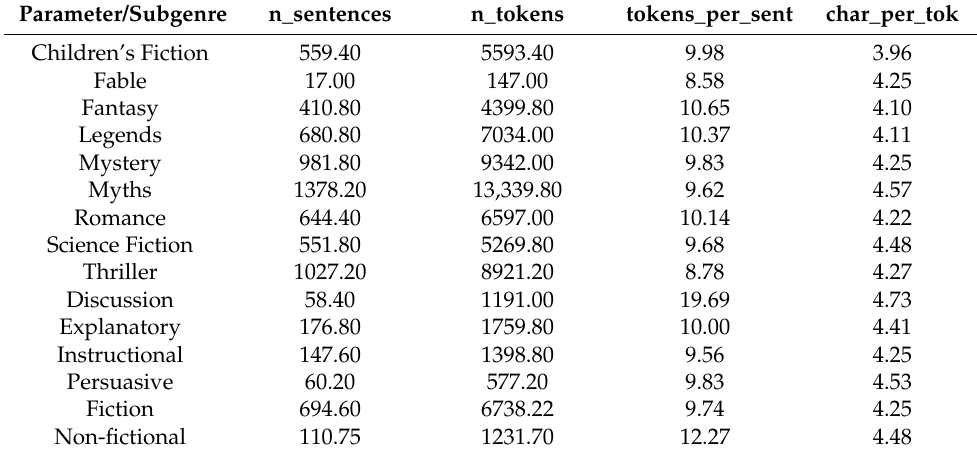
Table 3. Summary of the raw textual features across genres.